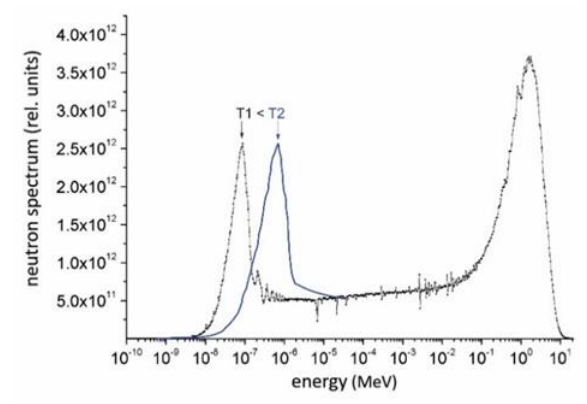
Figure 4: Lethargy neutron spectrum in standard (12 w/o) fuel in TRIGA Mark II reactor at JSI for two